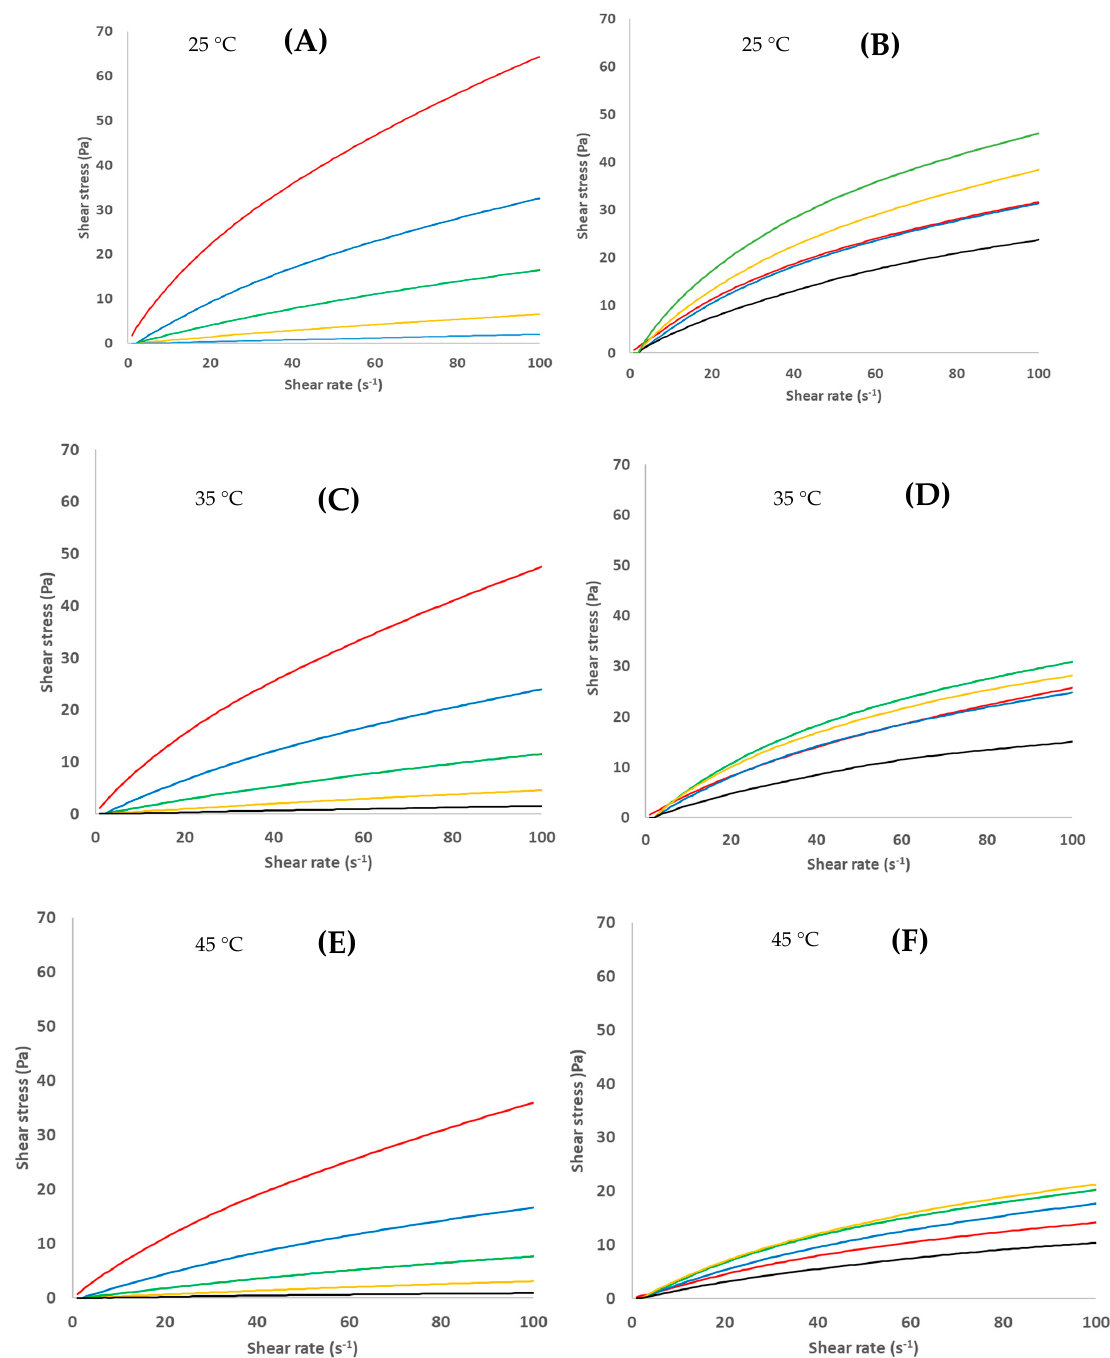
Figure 4. Flow curves of chitosan solutions prepared with several chitosan concentrations ( A , C , E ): 2.5 (red), 2.0 (blue), 1.5 (green), 1.0 (yellow), and 0.5% (black); and for several acetic acid concentrations ( B , D , F ): 1.0 (red), 0.8 (blue), 0.6 (green), 0.4 (yellow), and 0.2% (black).